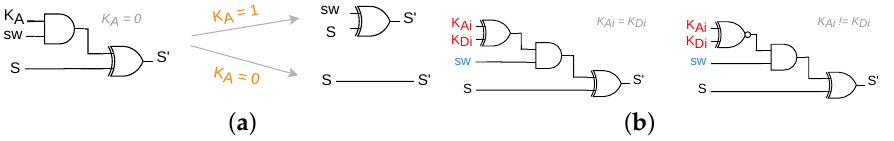
Figure 14. Vulnerability and countermeasure of SKG-Lock+ against the SCOPE attack: ( a ) vulnerabil- ity of SKG-Lock, ( b ) countermeasure based on a new SKG